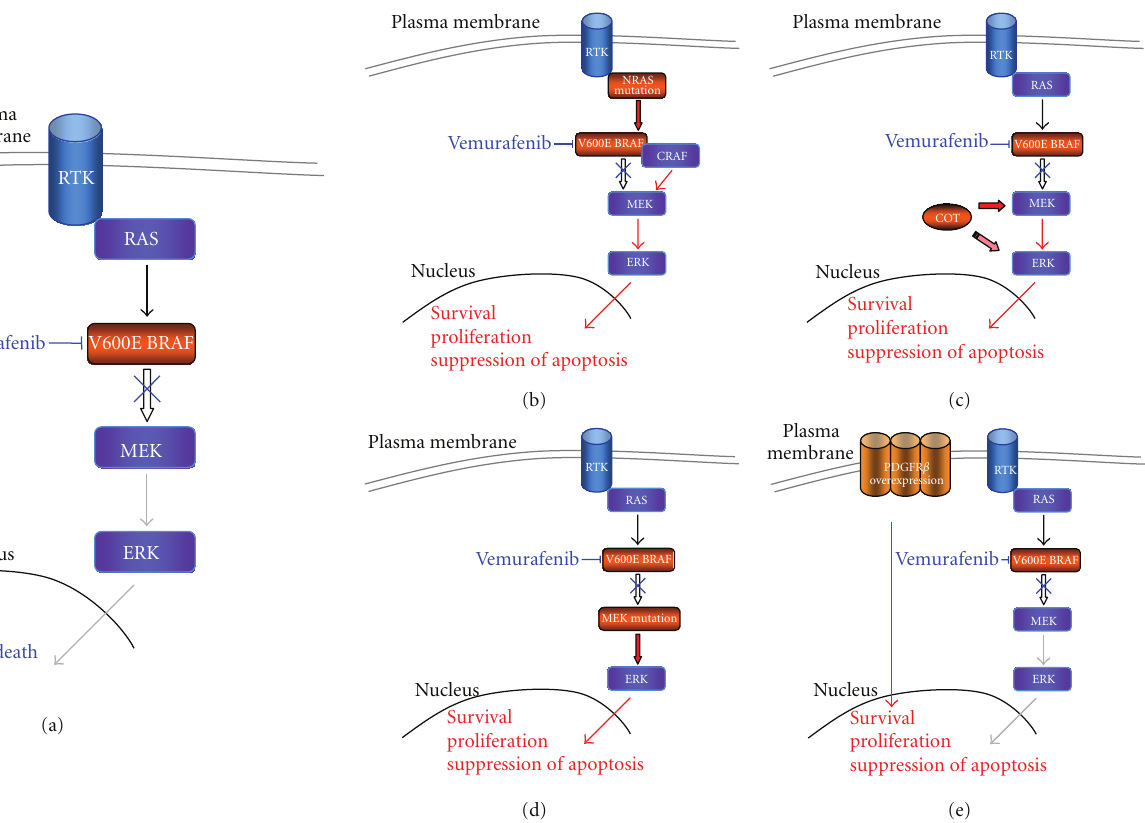
Figure 2: Representation of the resistance mechanisms to the vemurafenib. (a) Vemurafenib causes cell death by inhibiting V600E BRAF kinase activity and signaling transduction through the MAPK pathway. (b) New mutations in the NRAS causes heterodimerization of BRAF/CRAF and reactivation of the signaling pathway. (c) and (d) Phosphorylation of ERK independent of RAF stimulation is the result of the overexpression of COT (c) and of the additional mutation in MEK kinase (d). (e) Overexpression of PDGFR β can lead to resistance to vemurafenib treatment independent from the continuous inhibition of the MAPK